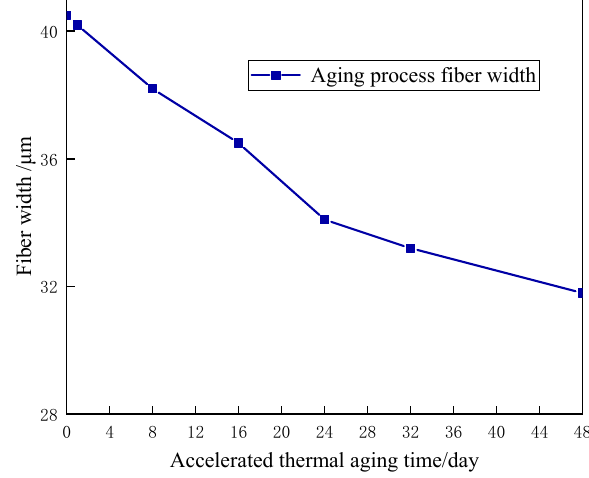
Figure 5. The average fiber width changes with time. Table 1. Statistical results of hole area.